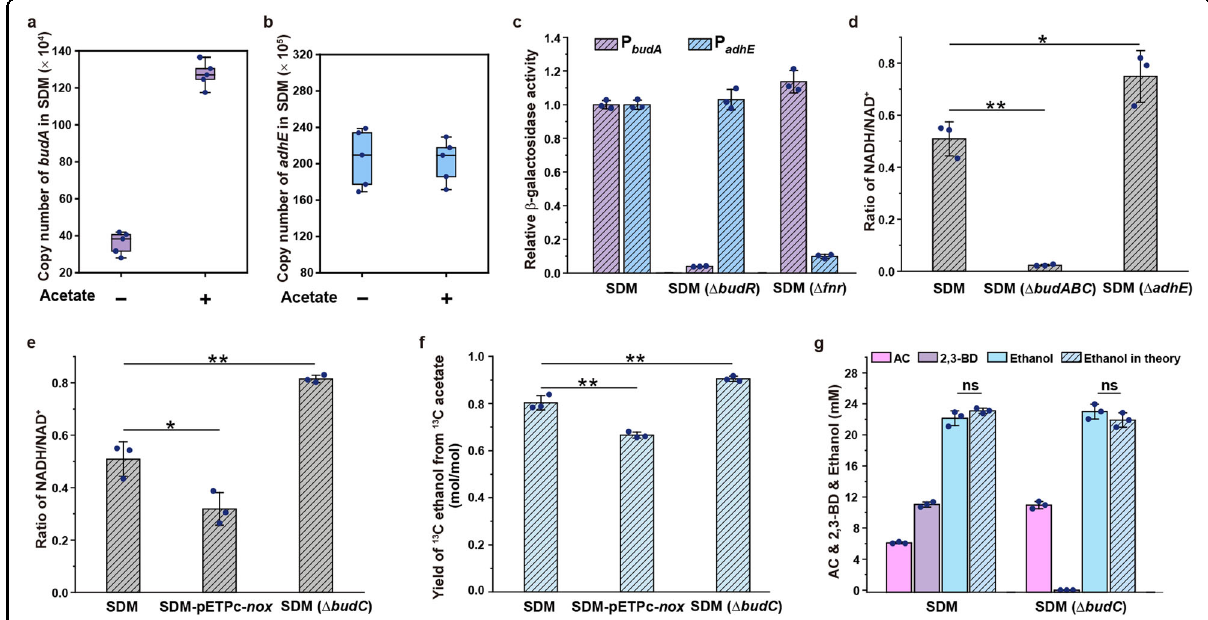
Fig. 2 Mechanism of 2,3-BD biosynthesis supports acetate elimination. a Copy numbers of budA in E. cloacae SDM during growth in glucose and glucose supplemented with 40 mM sodium acetate at mid-log stage ( n = 5). b Copy numbers of adhE in E. cloacae SDM during growth in glucose and glucose supplemented with 40 mM sodium acetate at mid-log stage ( n = 5). c Relative β -galactosidase activity in E. cloacae SDM, E. cloacae SDM ( Δ budR ) and E. cloacae SDM ( Δ fnr ) containing pME6522-P budA or pME6522-P adhE at mid-log stage. The β -galactosidase activity in E. cloacae SDM is assumed to be 1. d Ratio of NADH/NAD + in E. cloacae SDM, E. cloacae SDM ( Δ budABC ), and E. cloacae SDM ( Δ adhE ) at mid-log phase. e Ratio of NADH/NAD + in E. cloacae SDM, E. cloacae SDM-pETPc- nox , and E. cloacae SDM ( Δ budC ). f Yield of 13 C ethanol from 13 C acetate in E. cloacae SDM, E. cloacae SDM-pETPc- nox and E. cloacae SDM ( Δ budC ). 13 C sodium acetate at a concentration of about 10 mM was added into the culture system of these strains at 2 h. After 4 h of culture, the concentrations of 13 C ethanol and 13 C acetate were assayed. g Concentration of AC, 2,3-BD, ethanol, and the theoretical concentration of ethanol in E. cloacae SDM and E. cloacae SDM ( Δ budC ) when cultured under anaerobic conditions. Experiments in a − f were carried out under aerobic conditions. Data shown are means ± SD. ( n = 3 independent experiments). * P < 0.05 in two-tailed Student ’ s t -test; ** P < 0.01 in two-tailed Student ’ s t -test; ns, no signi fi cant difference ( P ≥ 0.05 in two-tailed Student ’ s t